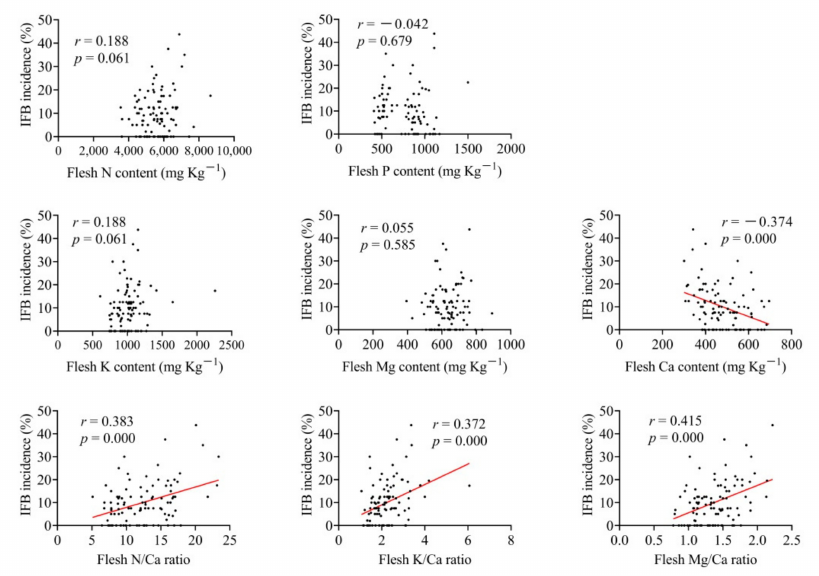
Figure 6. Relationship between IFB incidence and flesh N, P, K, Mg and Ca contents and flesh N/Ca, K/Ca and Mg/Ca ratios in 100 mango